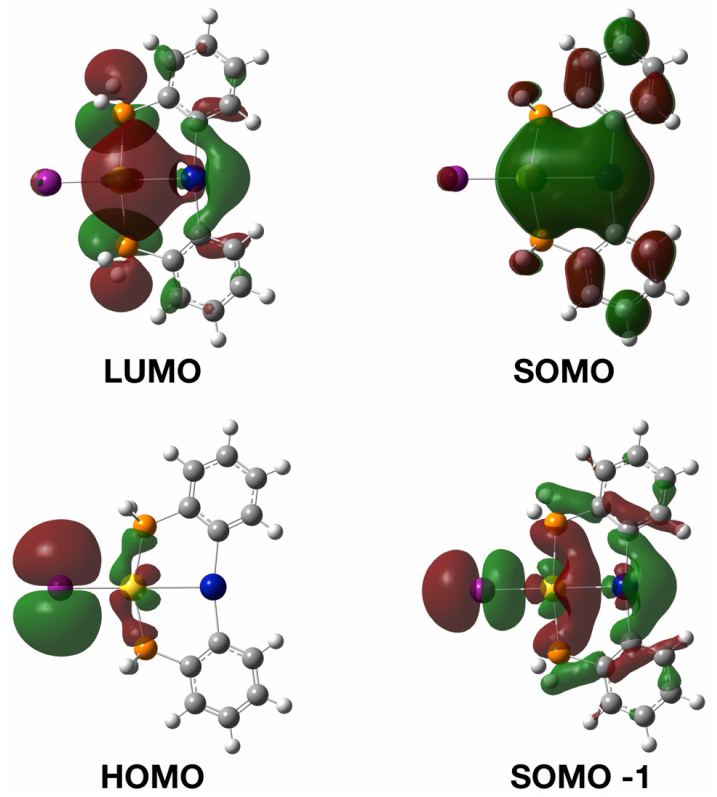
Figure 4. Frontier molecular orbitals for the model system 1a in the S 0 and T 1